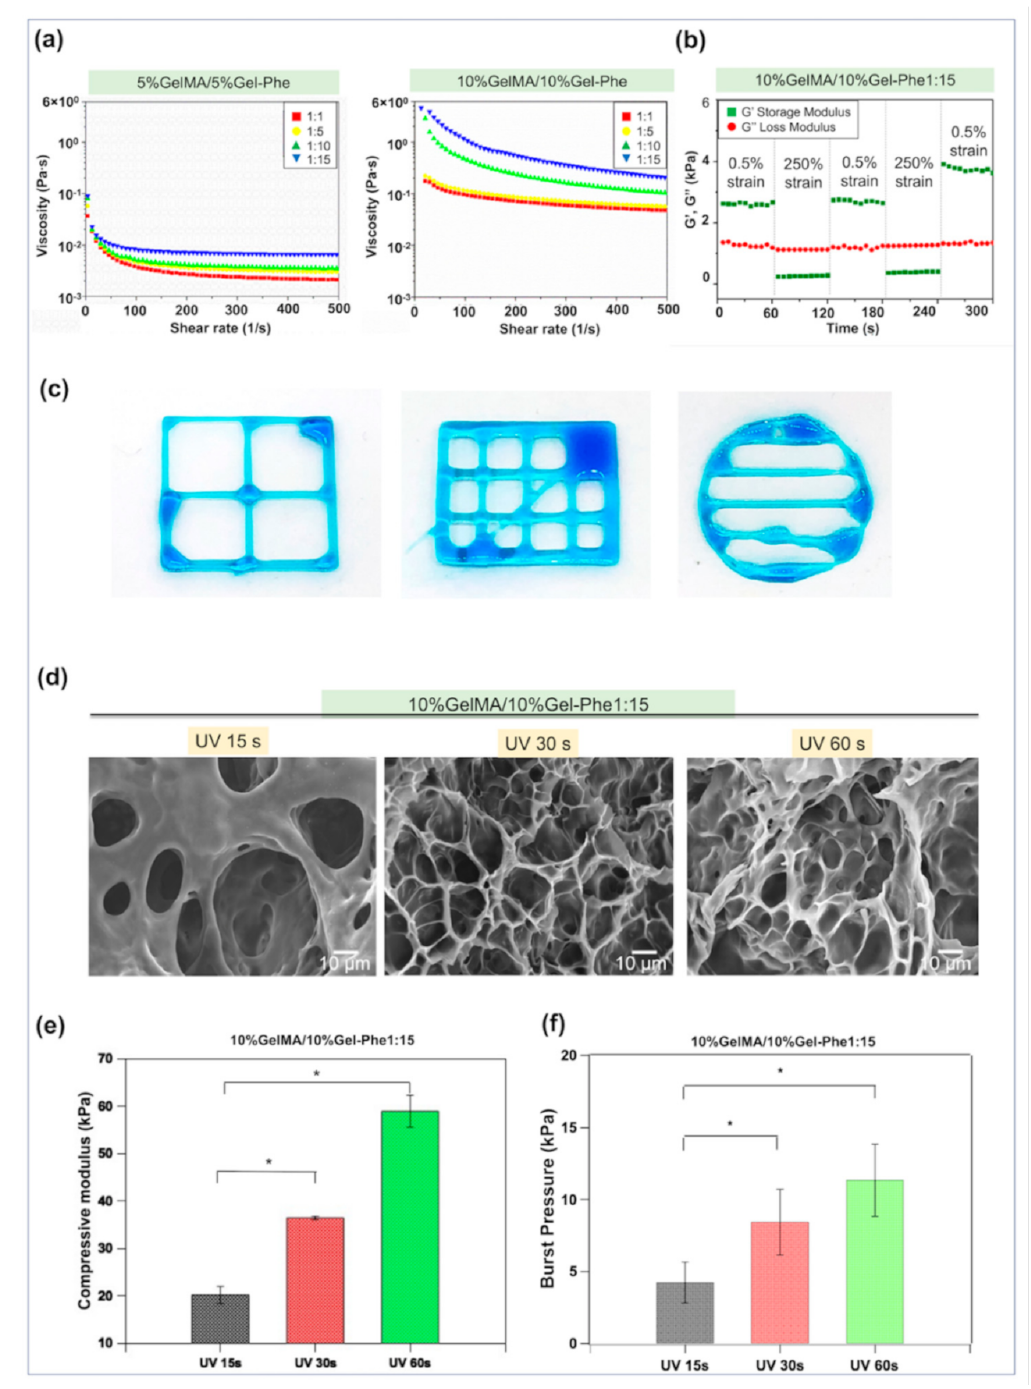
Figure 3. Evaluation of the injectable and mechanical properties of hybrid GelMA/Gel-Phe hydrogels. ( a ) The shear-thinning behavior and ( b ) the oscillatory strain sweep test between a low (0.5%) and high (250%) strain of the GelMA/Gel-Phe solutions. ( c ) The injectability testing of 10%GelMA/10%Gel-Phe1:15 solution through an extrusion bioprinter. ( d ) The SEM morphology, ( e ) compressive modulus, and ( f ) the in vitro burst pressure of hybrid 10%GelMA/10%Gel-Phe1:15 hydrogels after exposure to different UV times. *: p <